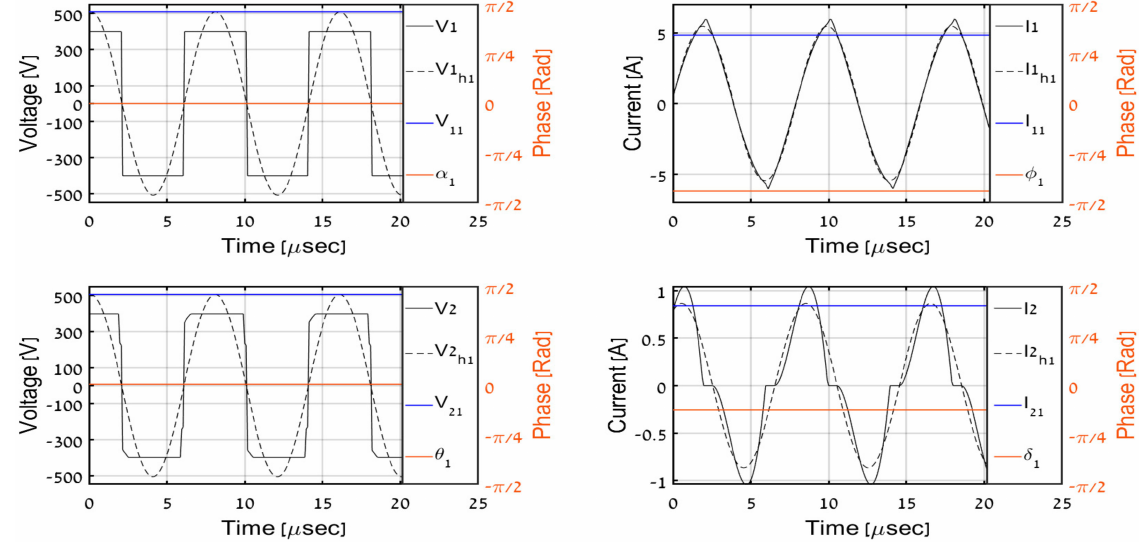
Figure 11. Simulation results, P O = 200 W.